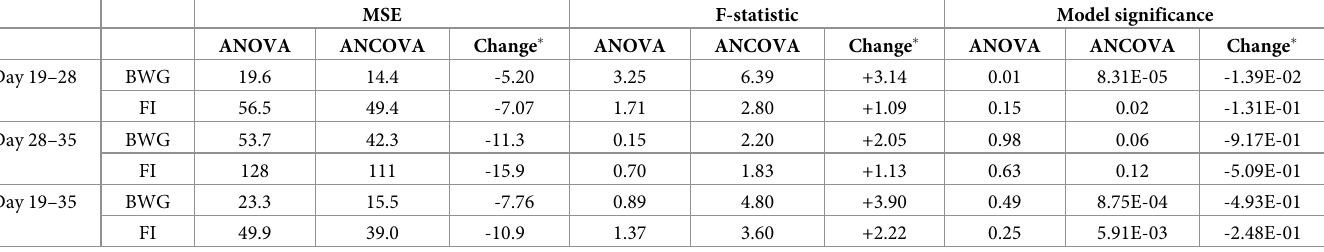
Table 11. MSE, F-statistic and model significance of performance data when analysed by a one-way ANOVA and ANCOVA during different phases for Experiment 4.